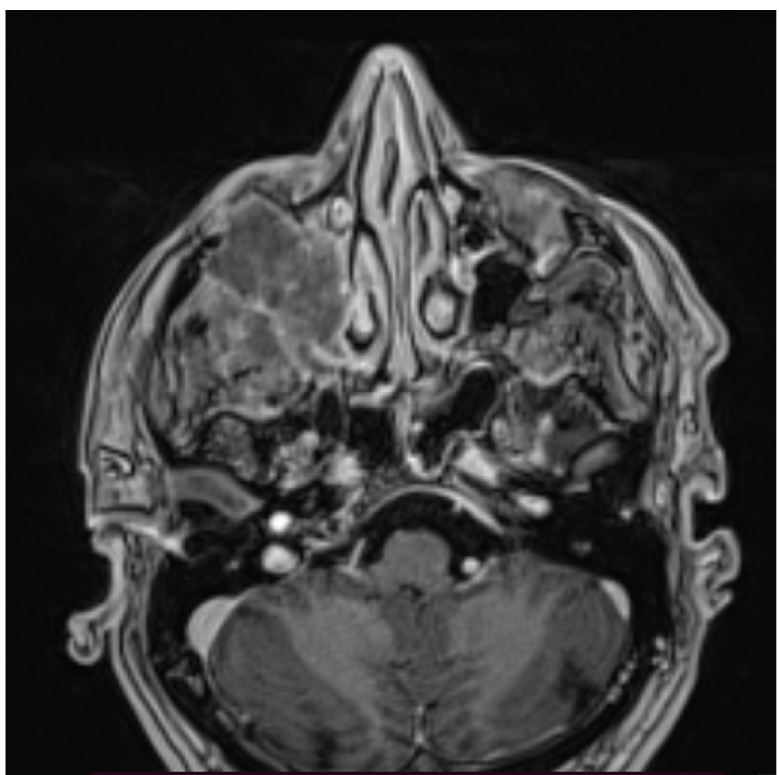
Figure 2. Head MR scan: large tumor evolving from maxillary sinus.